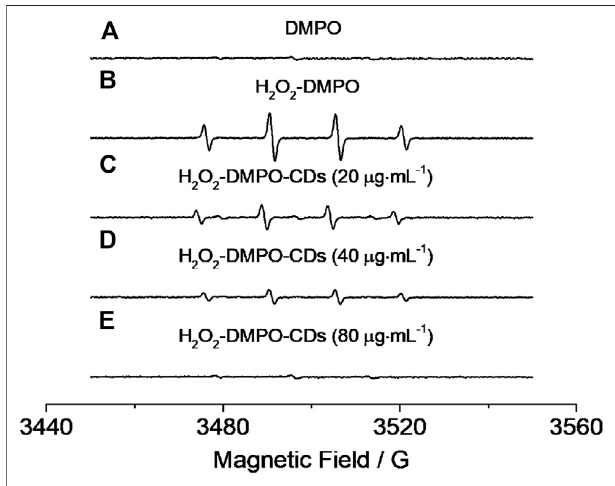
FIGURE 7 | EPR results of (A) DMPO, (B) H 2 O 2 – DMPO, and (C – E) H